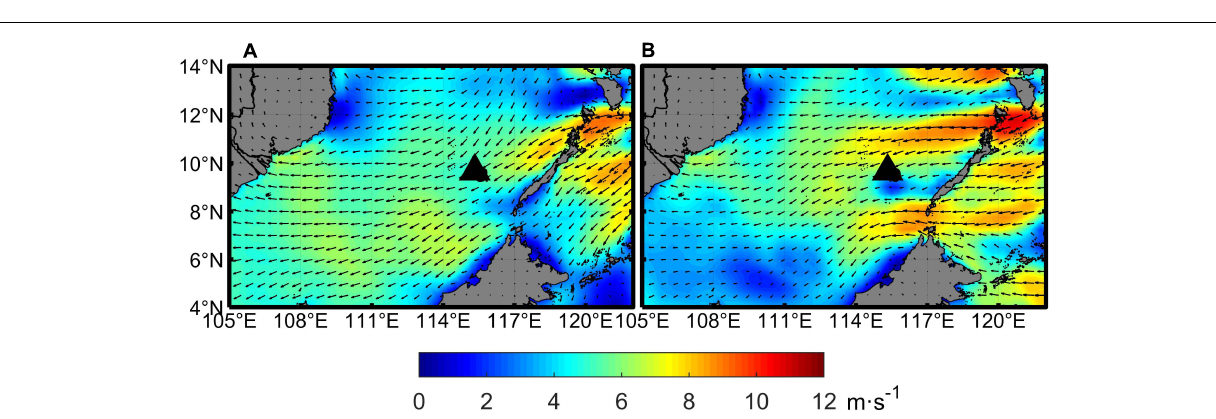
Frontiers in Marine Science |